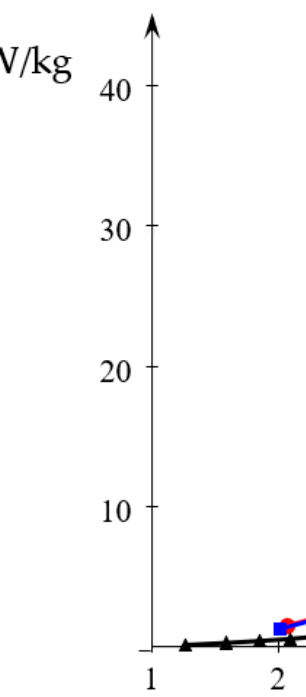
2 846 0 074 . . Q   ( Q is in L/min, ε is in